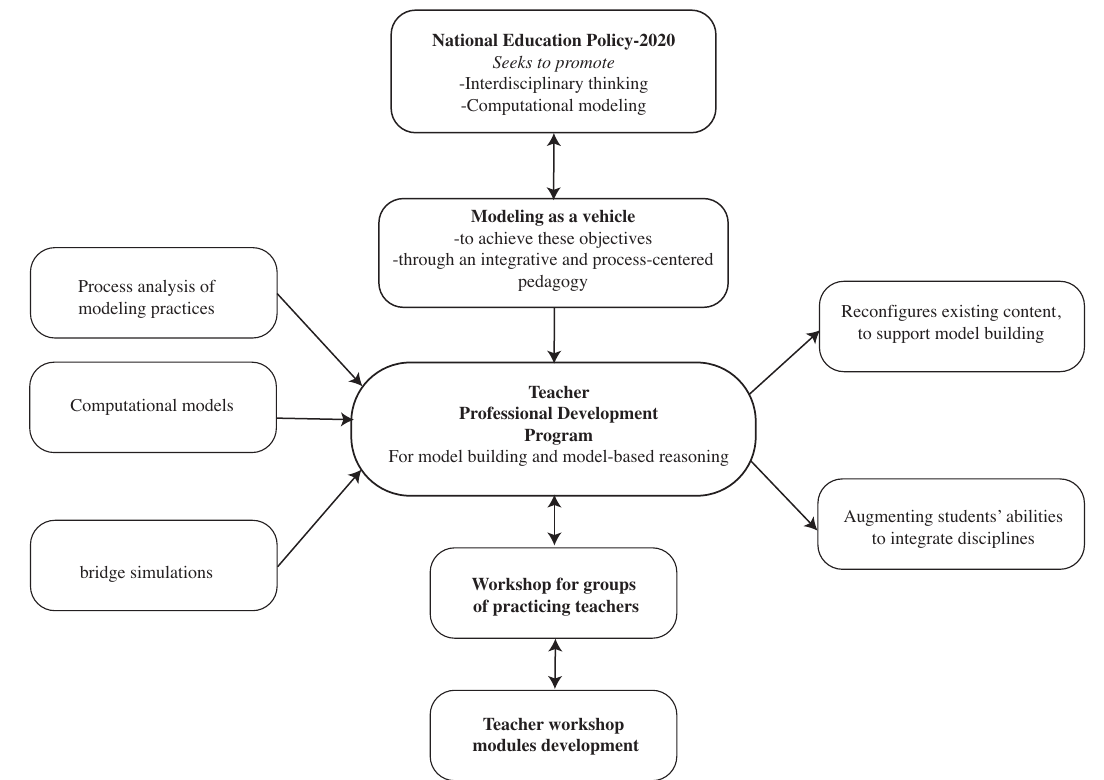
FIG. 1. A schematic of the design of our teacher professional development program and an outline of the key stages, components, and processes involved in this